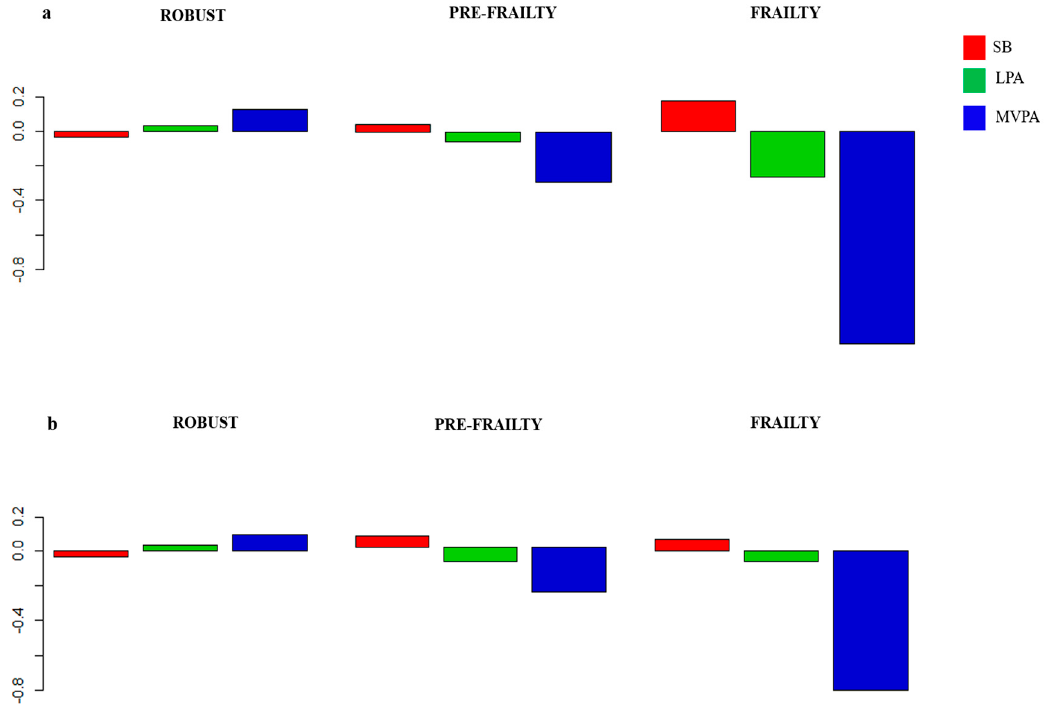
Figure 2. Movement patterns according to frailty status and sex: Compositional geometric mean bar plots comparing the compositional mean of the entire sample with the compositional mean of robust, pre-frail and frail subgroups for sedentary behavior (SB), light intensity physical activity (LPA) and moderate-to-vigorous intensity physical activity (MVPA) for male ( a ) and female ( b ) subgroups.